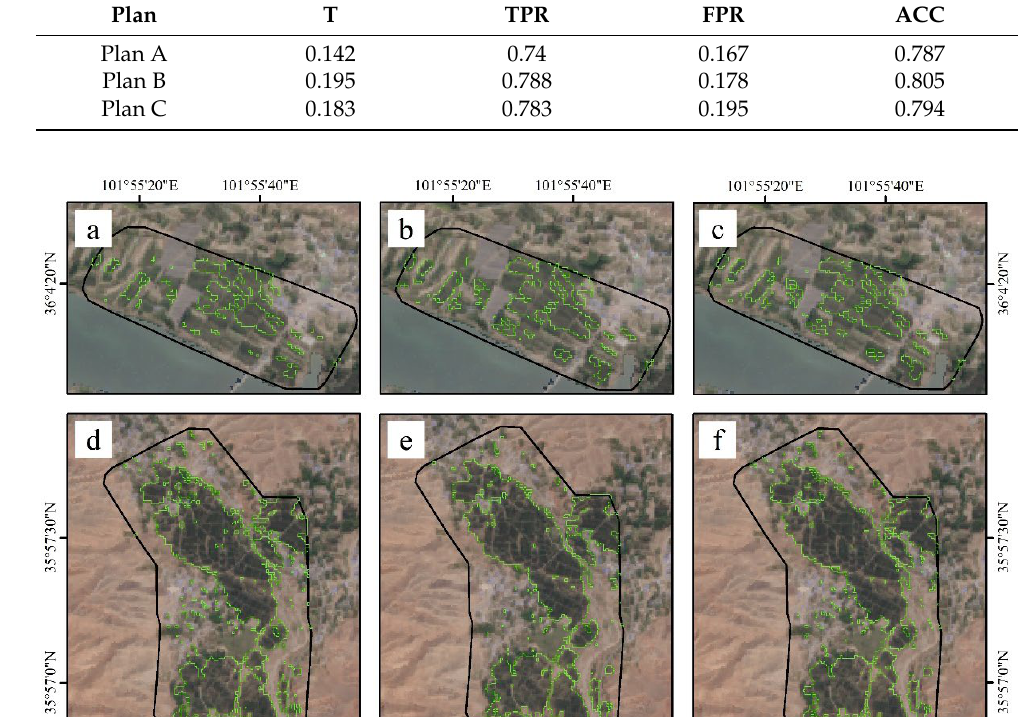
Table 6. DTW threshold and winter wheat extraction results of the combined time series of the op- timal phenological period combinations in the study area.